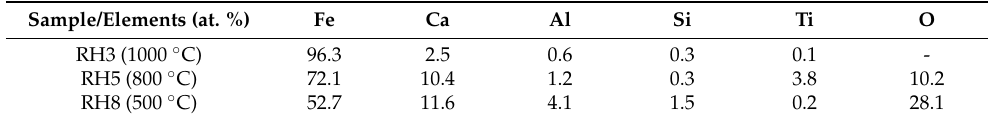
Table 2. Comparison of atomic fraction in EDS elemental analysis of RH3, RH5 and RH8. Sample/Elements (at.